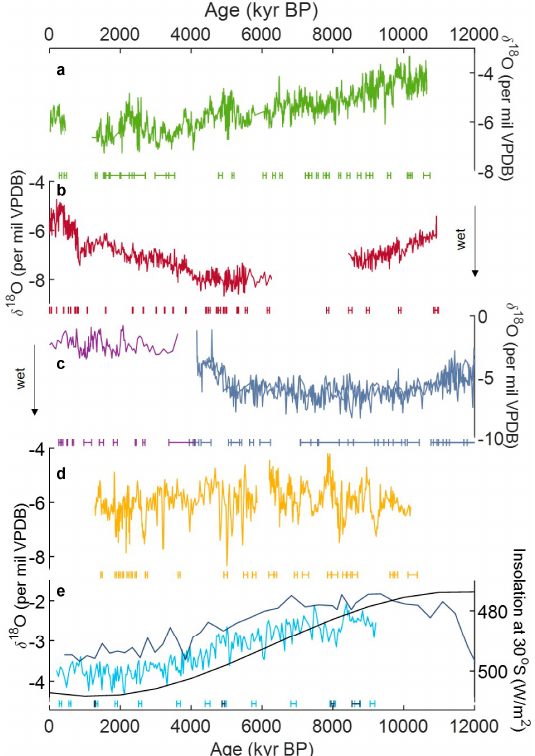
Figure 7. Holocene speleothem δ 18 O time series indicating precipitation changes associated with the variability of the SAMS. ( a ) Shatuca Cave (Sha-2 and Sha-3), ( b ) Paraiso Cave (PAR01, PAR03, and PAR16) and ( c ) Rio Grande do Norte, Nordeste, (RN-1, RN-4, FN1), ( d ) Lapa Grande (LG3 and LG11), and ( e ) Botuver á Cave (BT-2 and BTV21a). Different colours indicate individual speleothems for the same cave (e.g., Lapa Grande or Botuver á Cave). The error bars show the 2-sigma age uncertainty of individual U-Th ages for all